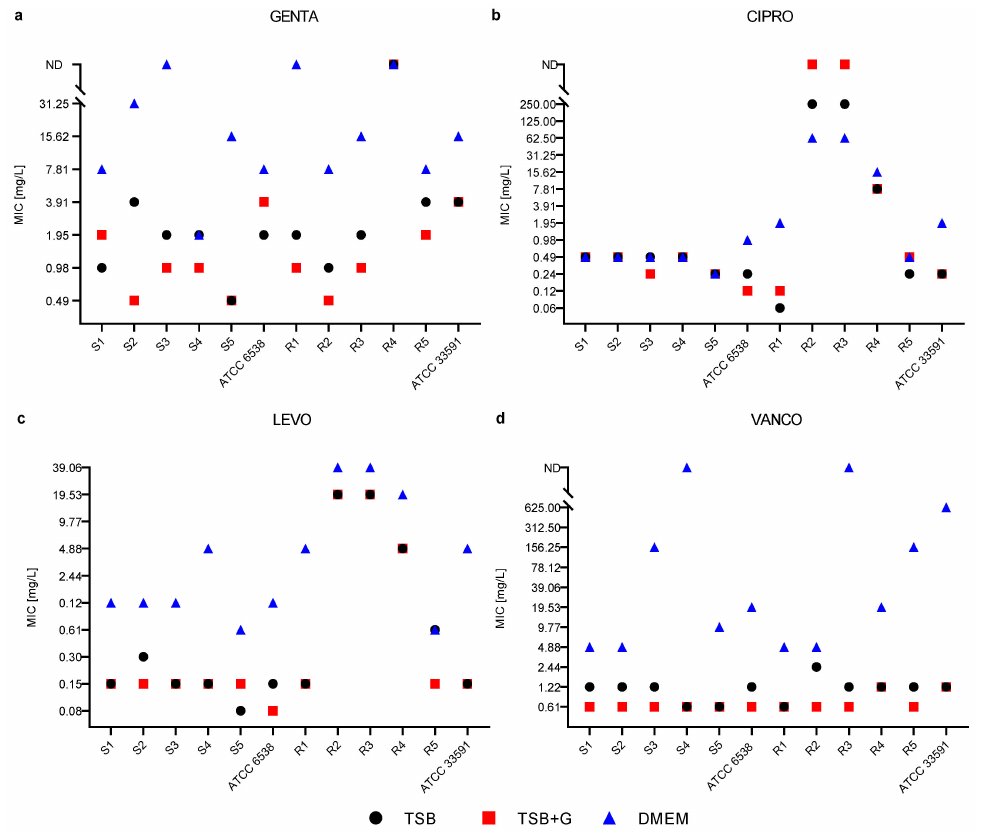
Figure 2. Minimal inhibitory concentrations MIC of gentamycin GENTA ( a ), ciprofloxacin CIRPO ( b ), levofloxacin LEVO ( c ), and vancomycin VANCO ( d ) of methicillin-susceptible S1–S5, methicillin- resistant R1–R5 and American Type Culture Collection ATCC Staphylococcus aureus strains cultivated in three media: tryptic soy broth TSB, tryptic soy broth with 1% glucose TSB + G and Dulbecco’s Modified Eagle Medium DMEM; ND—refers to the indeterminable minimal inhibitory concentration in the tested concentrations. Table 2. Differences in minimal inhibitory concentrations MIC of gentamycin GENTA, ciprofloxacin CIPRO, levofloxacin LEVO and vancomycin VANCO between strains cultivated in three media: tryptic soy broth TSB, tryptic soy broth with 1% glucose TSB + G and Dulbecco’s Modified Eagle Medium DMEM. Arrow up indicates that the average MIC value in a particular medium was higher than in another medium (arrow down); p —probability level, for p < 0.05 differences were statistically significant and marked as (*) 0.033 and (***) < 0.001, while ns refers to differences